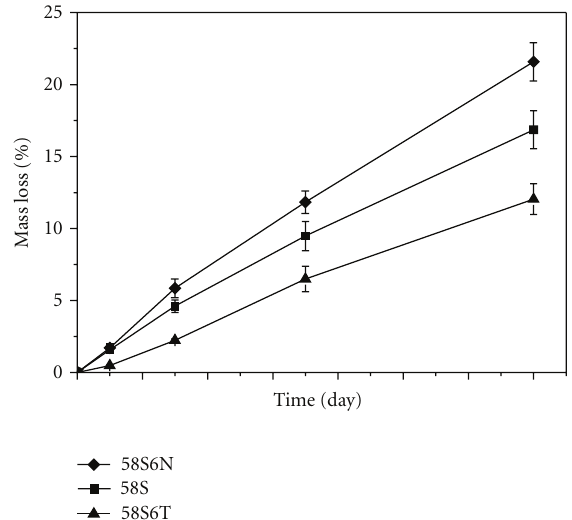
Figure 3: Dissolution behavior of di ff erent bioactive glasses in Ringer’s solution for 14 days.